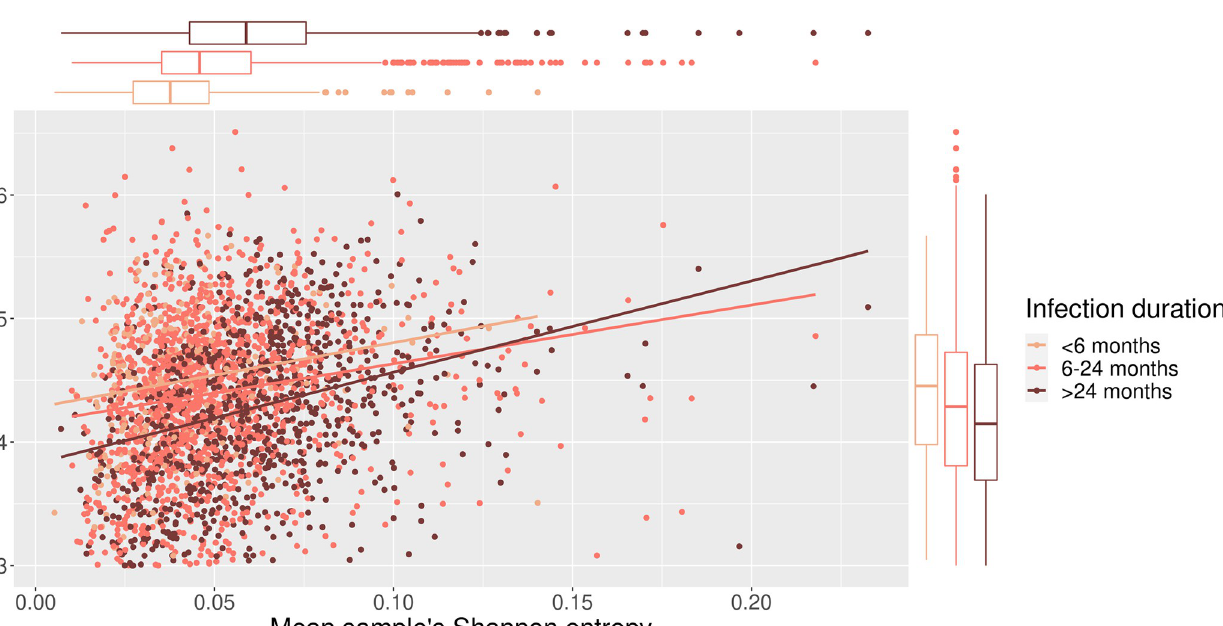
Fig 1. Mean Shannon entropy over the HIV genome (top) and number of samples with minimum 500-fold genome sequencing depth over the genome (bottom). A total of 2,447 HIV AA positions are shown on the x-axis. Gag positions 1–239, Pol positions 981–1004, Rev positions 1–6 and Tat positions 1–51 are not shown, as they were not covered by the amplicons. Red horizontal line in the top figure shows the used Shannon entropy threshold. Grey points at the top plot mark the HIV genome positions which were excluded from the analysis ( � 800 samples). Grey horizontal line at the bottom plot shows the threshold for the minimum number of samples.